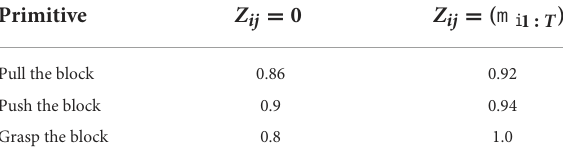
TABLE 1 Success rates of trained models for sensitive